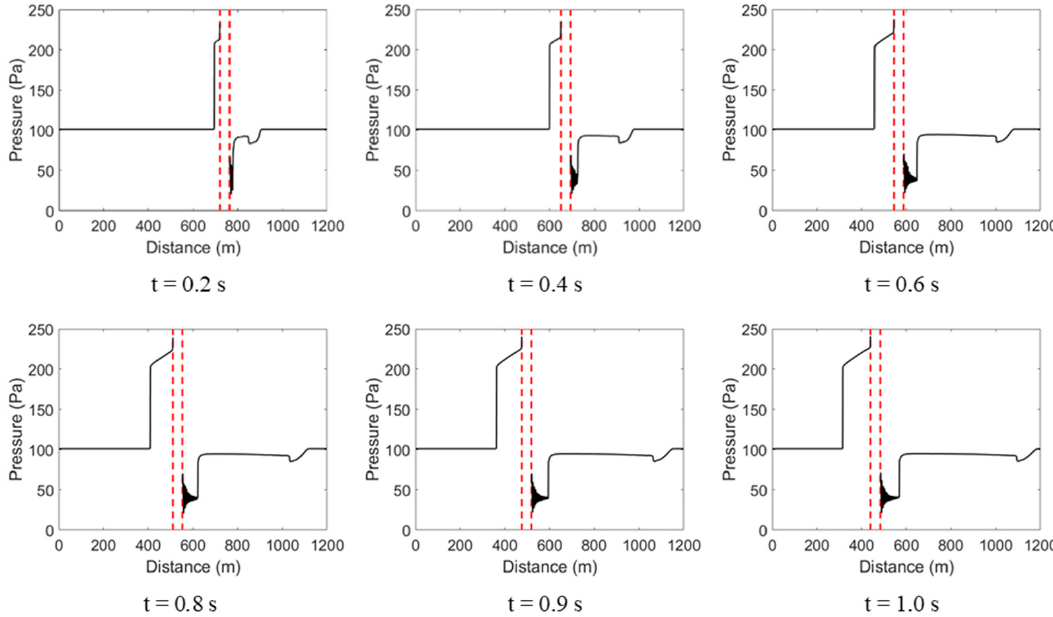
Figure A1. Pressure line plot along the centerline in the front and rear of the pod varied with simulation time ( v P = 350 m / s). The simulation was terminated before the expansion wave could reflect off from the outlet boundary.